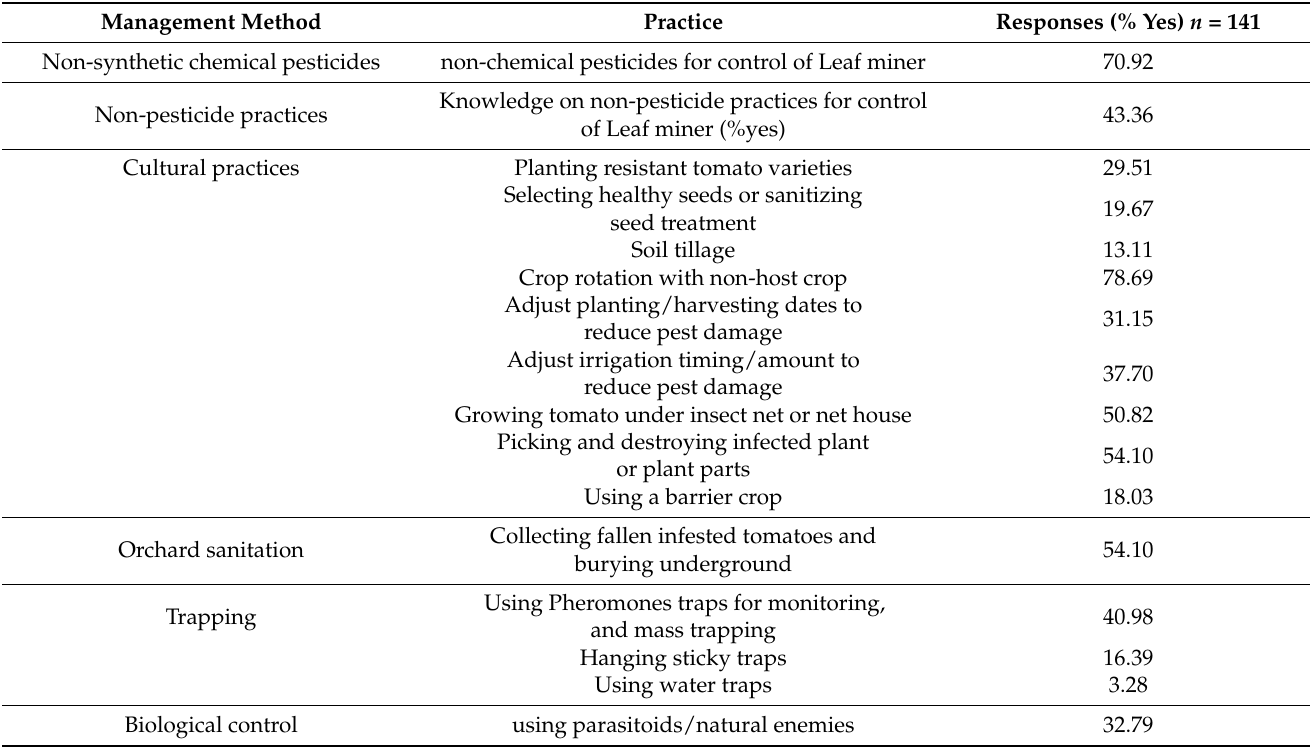
Table 2. Agro-dealers’ knowledge of biopesticides and other non-pesticide practices in Kirinyaga